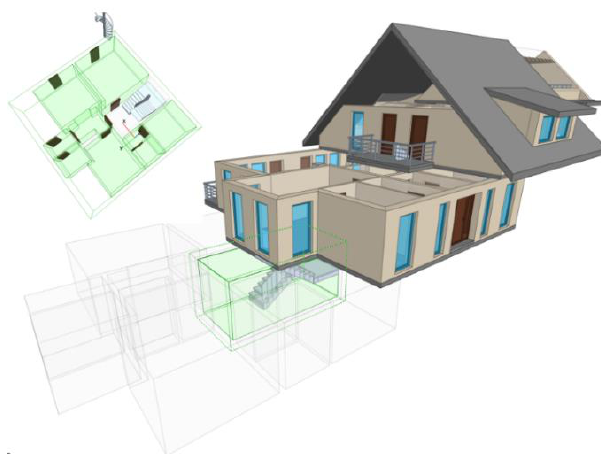
Figure 6: Example of space subdivision according to different property rights